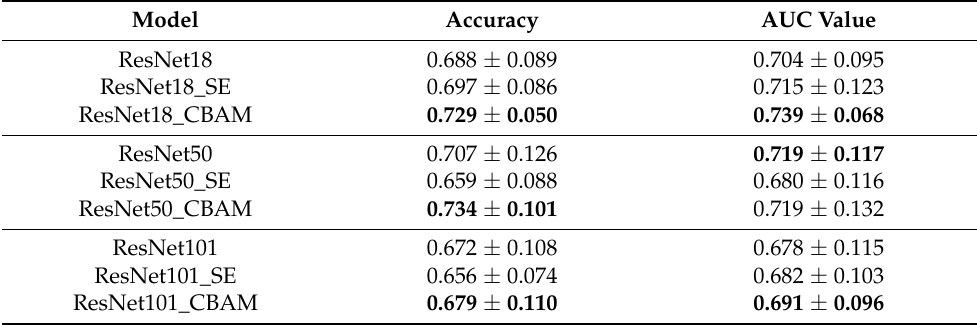
Table 2. Test performance of the backbone models (mean ± SD).